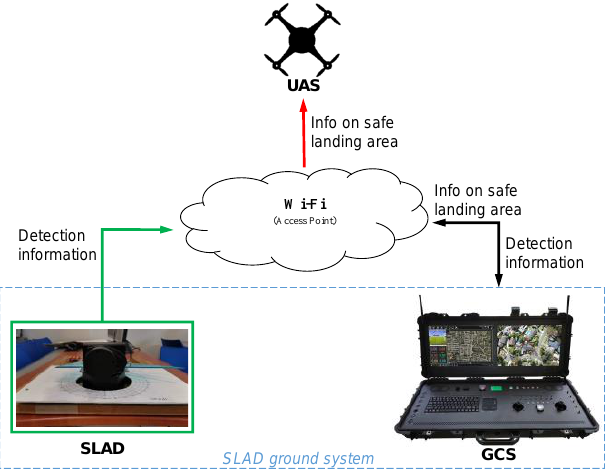
Figure 10. Block scheme of the communication subsystem.